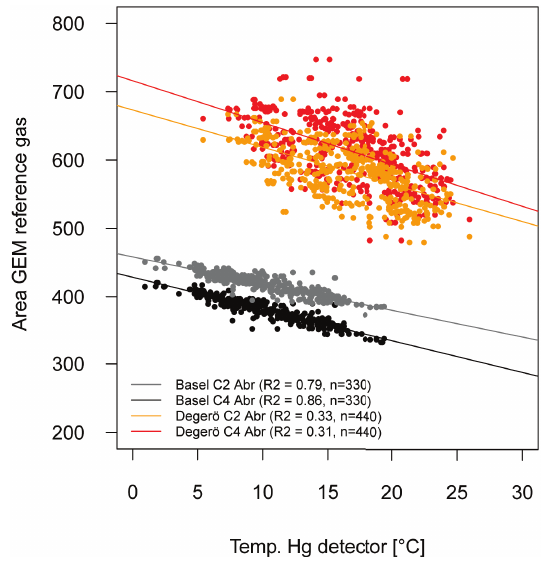
Figure 4. Linear relationship between GEM reference gas (Abr) measured with gold cartridge pair C2–C4 in Basel (grey, black) and Degerö (orange, red) and air temperatures within the Hg detector